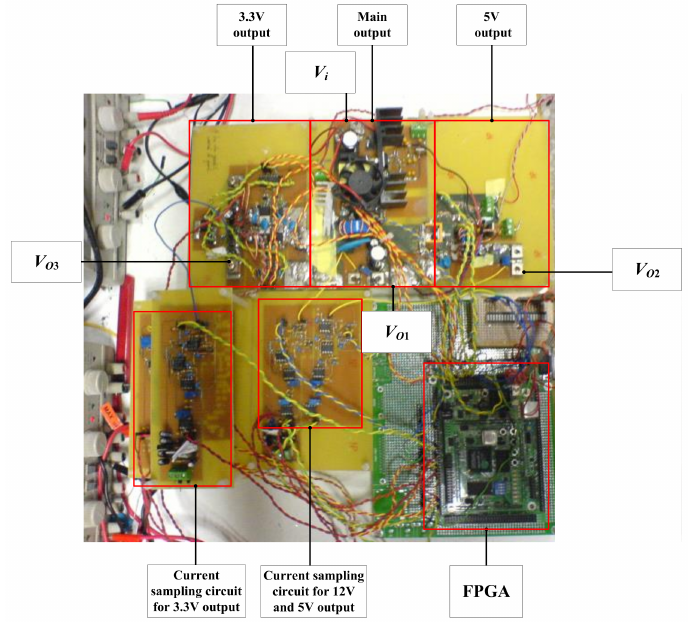
Figure 27. Photo of the experimental setup.